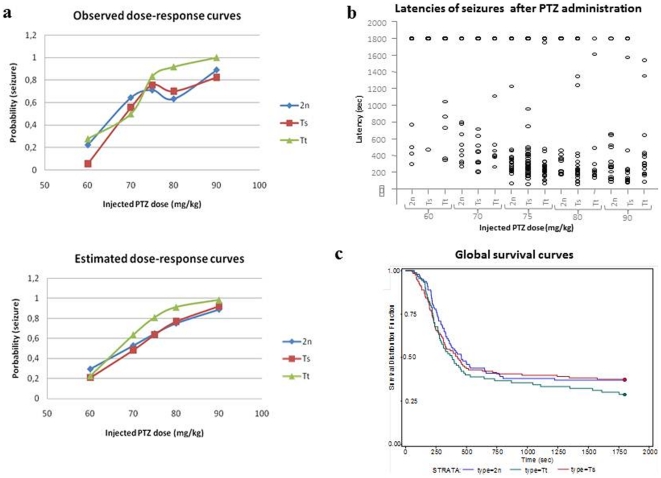
Evaluation of susceptibility of 2n, Ts and Tt mice to PTZ-induced seizure.(a) Dose-response curves showing the ratio of the number of convulsing mice observed (obs) or predicted (pred) to the total number of injected animals for each PTZ dose. (b) Distributions of latencies of seizure for each genotype at the different doses of PTZ administered. (c) Global survival curves of 2n (blue), Ts (red) and Tt (green) mice (probability of seizure according to time, latencies right censored at 1800 sec).